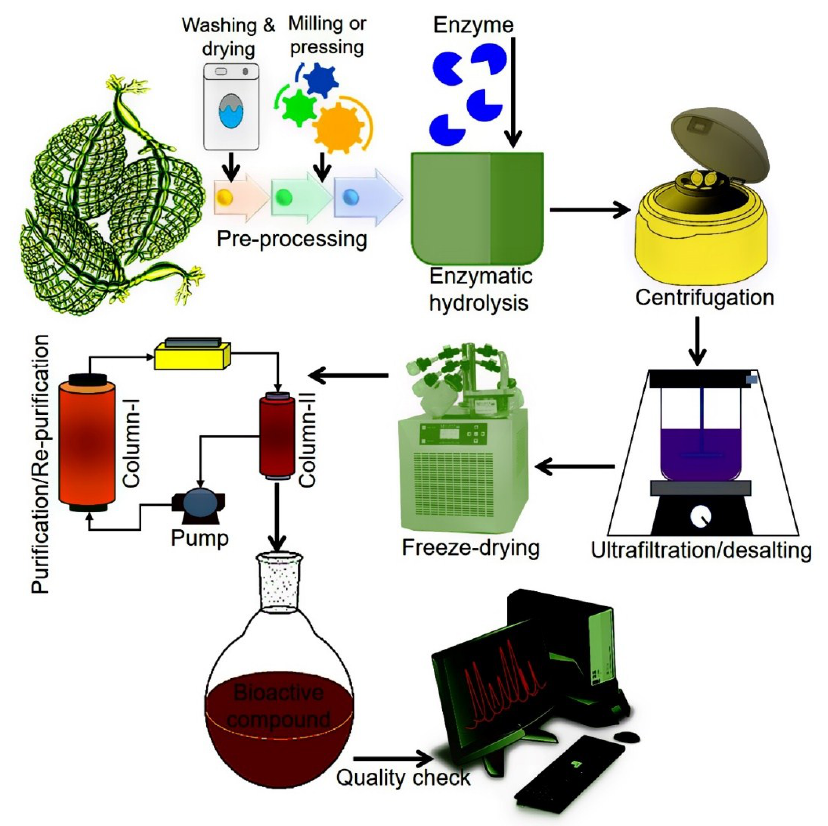
Figure 5. A simplified schematic flow of EAE of algal-based bioactive compounds.